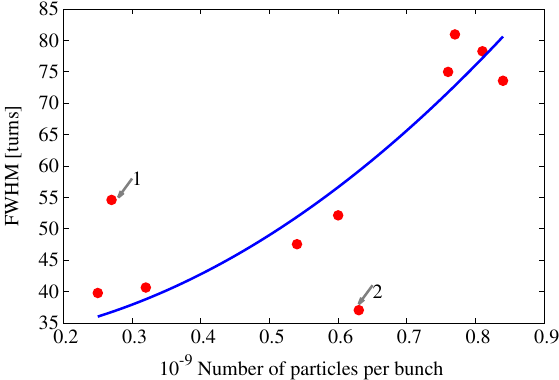
FIG. 7. FWHM vs the number of particles per bunch. Except for the points labeled 1 and 2, all the other data points show an increasing FWHM with bunch charge. The blue curve shows a quadratic fit through these